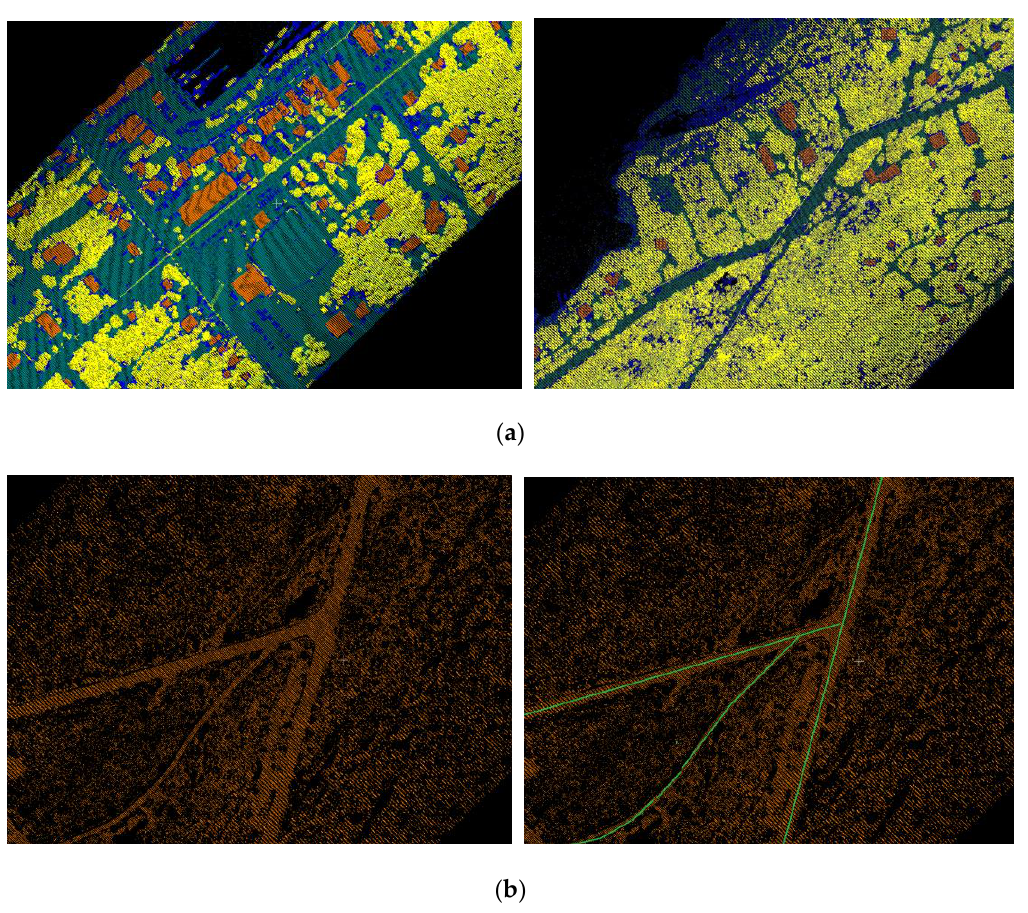
Figure 6. Point cloud classification using RF: ( a ) the output for the urban area of Tobermory ( left ) and a rural area ( right ). Points are colorized according to the identified class (building = red, tree = yellow, ground = green, unclassified = blue); ( b ) an example of ground segment in a rural area, roads are characterized by a high point density for bare soil.